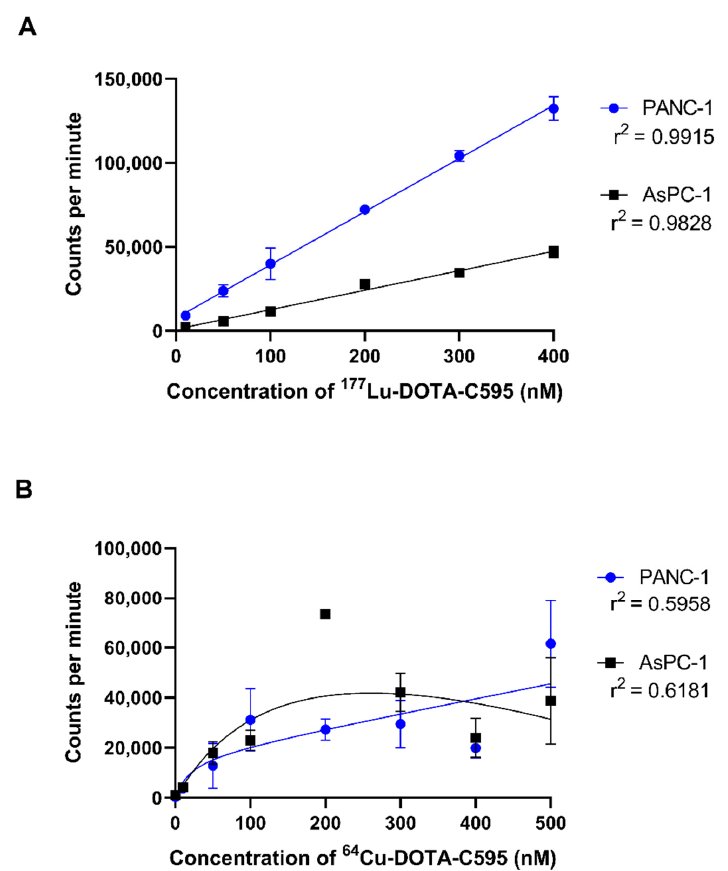
Figure 10. Repeated cell binding assays performed using ( A ) stored 177 Lu-DOTA-C595 and ( B ) stored 64 Cu-DOTA-C595. Data presented as mean ± standard deviation.